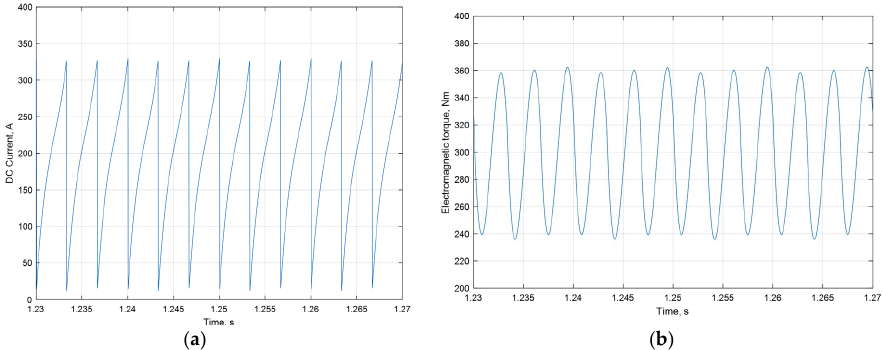
Figure 16. DC-link current ( a ), electromagnetic torque ( b ) of 3PIM supplied by 6-step VSI in steady-state mode. Using the 6PIM with a displacement of the three-phase windings in space by angle π =β and the phase shift of the windings’ currents by angle 6 harmonic elimination of the DC-link current (Figure 17a), the electromagnetic torque (Figure 17b), and the rotor currents (Figure 18b). In this case, there is 12th harmonic in their composition. The ripple amplitude of the DC-link current for the 6PIM is 1.18 times smaller compared to the 3PIM. The ripple amplitude of the electromagnetic torque for the 6PIM is six times smaller compared to the 3PIM.